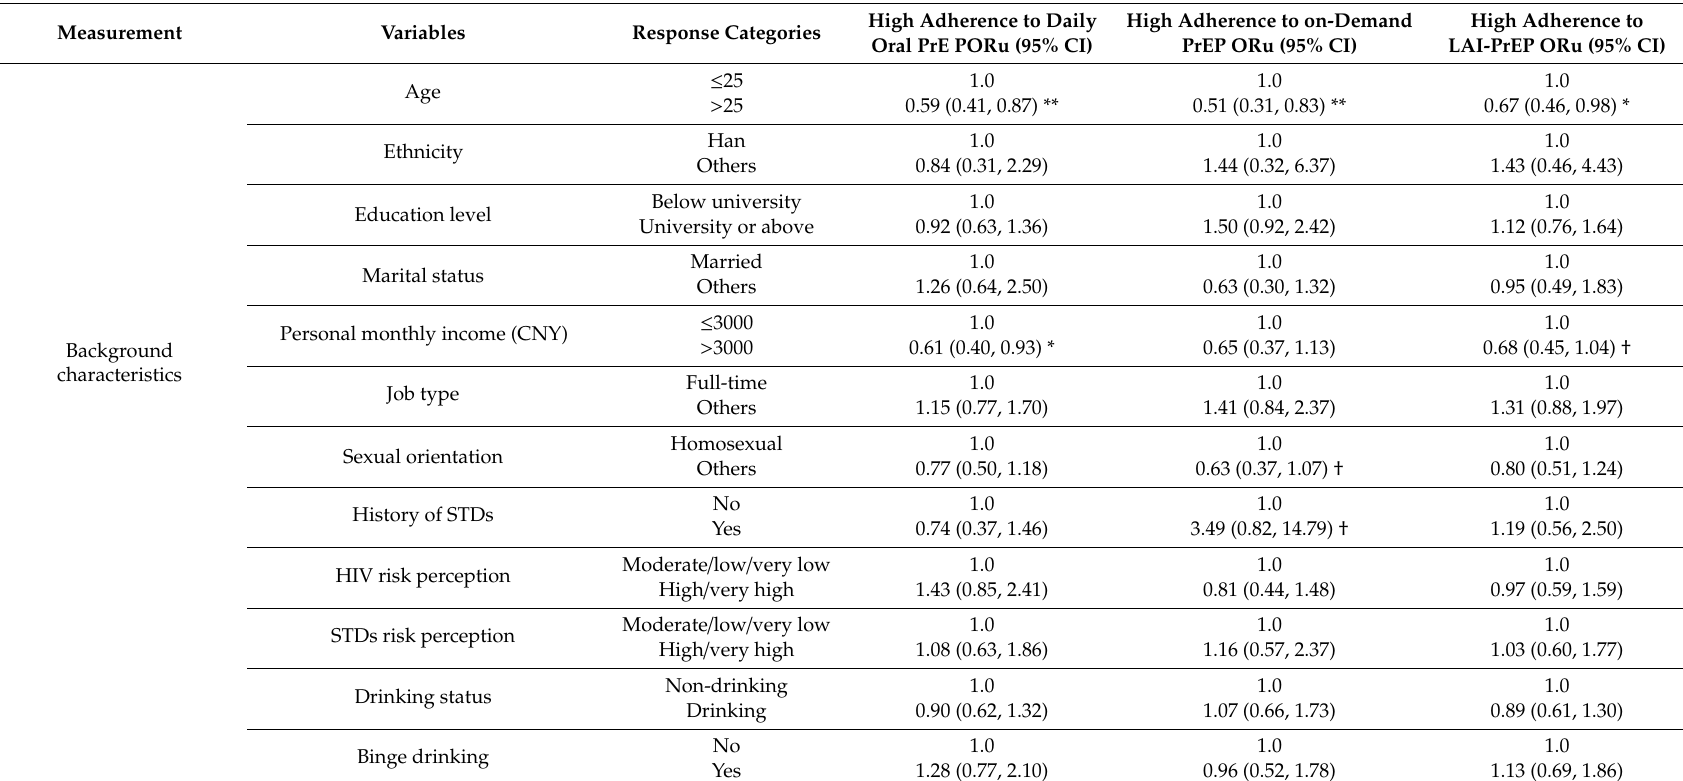
Table 4. Association between variables and adherence to